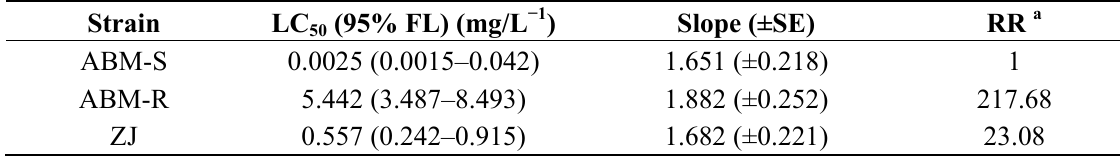
Table 1. Susceptibility of Plutella xylostella strains to abamectin